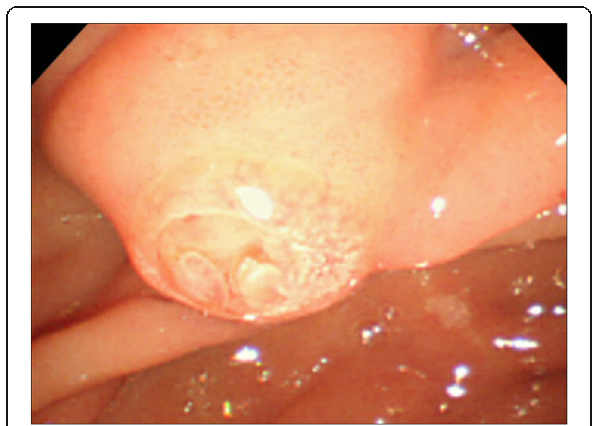
Fig. 3 Endoscopic retrograde cholangiopancreatography showed an unexposed tumor at the papilla of Vater